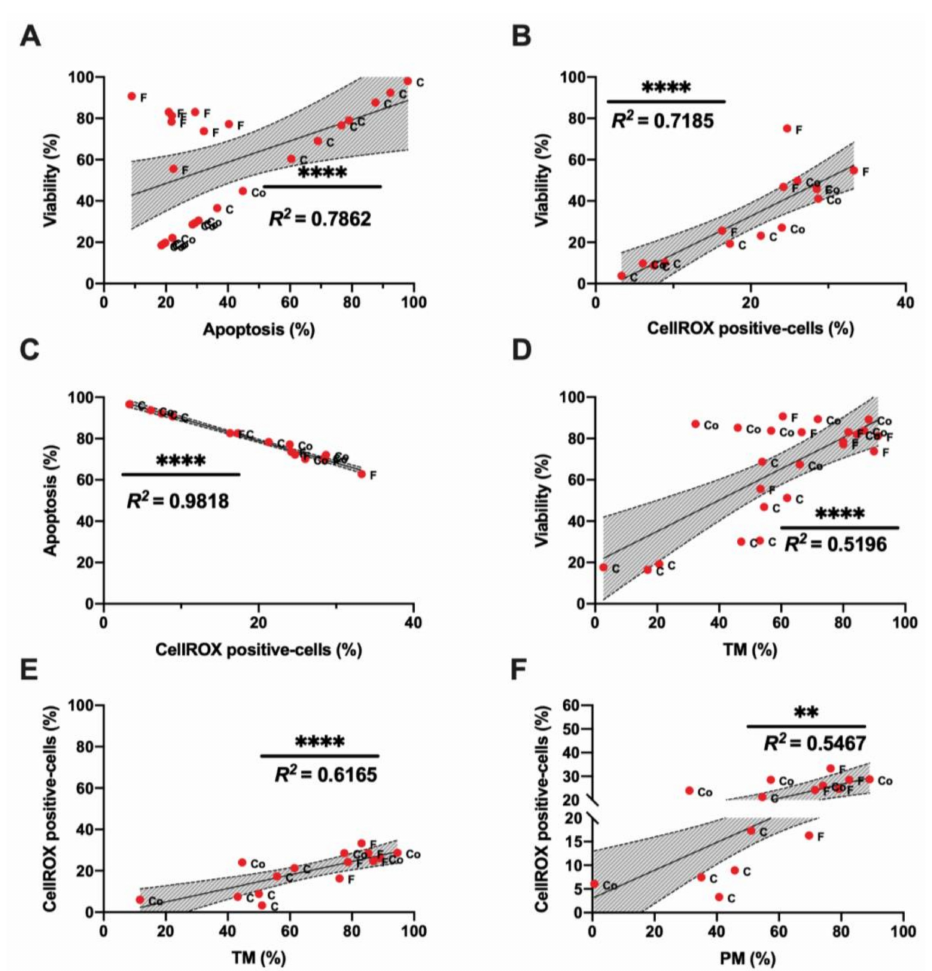
Figure 2. Correlations of ram sperm flow cytometry and motility parameters in the three experimental groups: fresh (F), cooled (Co) and cryopreserved samples (C). ( A ) Correlation between viability (%) and apoptosis (%); ( B ) correlation between viability (%) and CellROX-positive cells (%); ( C ) c orrelation between apoptosis (%) and CellROX-positive cells (%); ( D ) correlation between viability (%) and total motility (TM, %); ( E ) Correlation between CellROX-positive cells (%) and total motility (TM, %); ( F ) c orrelation between CellROX-positive cells (%) and progressive motility (PM, %). The same five-eight males were analyzed in each experimental group. In correlation studies, a significant correlation is represented by a di ff erent number of asterisks; the R squared value is included in each graph. Non-significant correlations are included in the correlation matrix (Appendix A, Figure A2). The number of asterisks (*) indicates the significance levels: two asterisks (**) indicate p < 0.01 and four asterisks (****) indicate p < 0.0001. Red dots represent all males (five–eight). Each dot is identified by a label with its experimental group (F-fresh, Co- cooled and C-cryopreserved